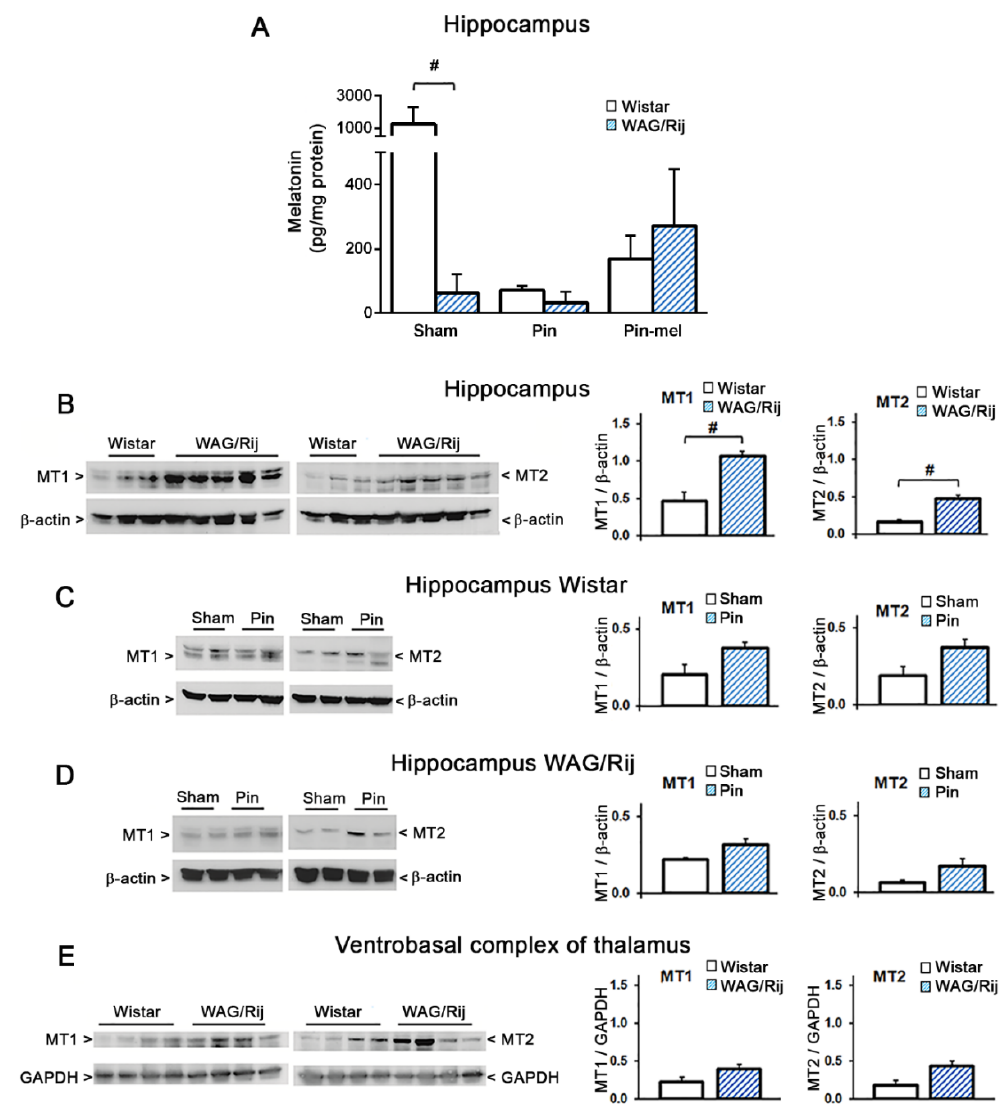
Figure 2. Changes in hippocampal melatonin and levels of MT1 and MT2 protein receptor levels in WAG/Rij rats. ( A ) Hippocampal levels of melatonin in Wistar and WAG/Rij rats under basal conditions (Sham), 24 days after surgical removal of the pineal gland (Pin), and after melatonin replacement (10 mg/kg, s.c., daily for 18 days, administered at 5.30 p.m.). (#) p < 0.05 between intact WAG/Rij and Wistar rats; ( B ) Western blot analysis of MT1 and MT2 receptors in the hippocampus of Wistar and WAG/Rij rats. (#) p < 0.05 between WAG/Rij and Wistar rats; ( C ) Effect of pinealectomy on hippocampal MT1 and MT2 receptor levels in Wistar rats and the representative Western blots on the left; ( D ) Effect of pinealectomy on hippocampal MT1 and MT2 receptor levels in WAG/Rij rats and the representative Western blots on the left; ( E ) Western blot analysis of MT1 and MT2 receptor protein levels in the ventrobasal thalamus of Wistar and WAG/Rij rats. All values are means + S.E.M. Statistical analysis was performed using the Mann–Whitney U test.